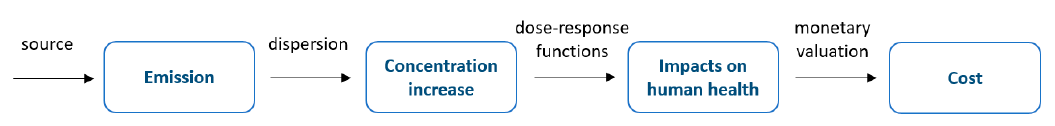
Figure 2. Impact Pathway Approach (Adapted from [45]).